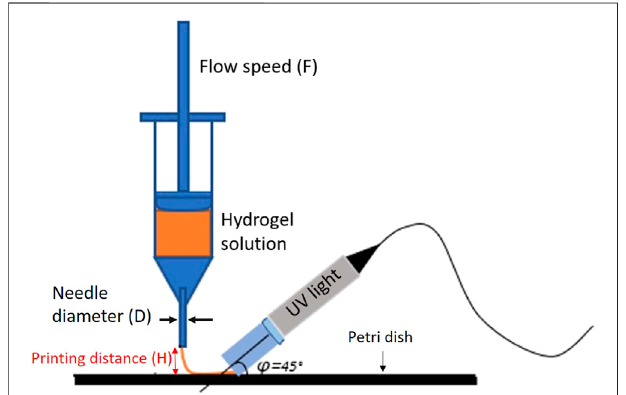
FIGURE 1 | Graphic explanation of the printing system and printing parameters de fi